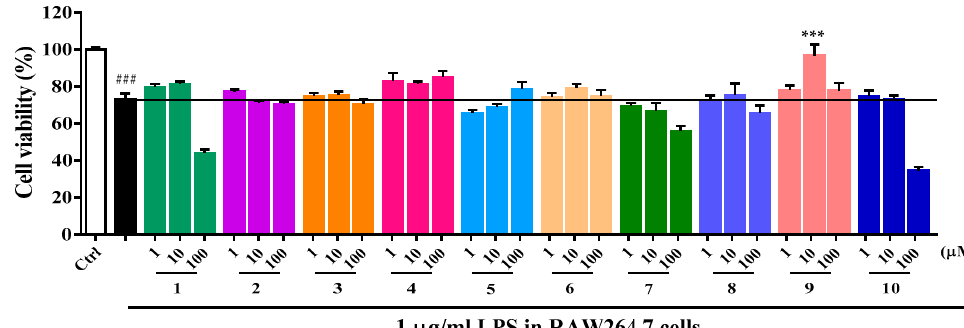
Figure 5. Protection by compounds 1 – 10 in RAW264.7 cells induced by LPS (n = 4). Data are expressed as the mean ± SEM of three separate experiments. The black column indicates the cell viability of LPS (1 µg/mL). ### p < 0.001 versus control group (Ctrl), *** p < 0.001 versus LPS group.